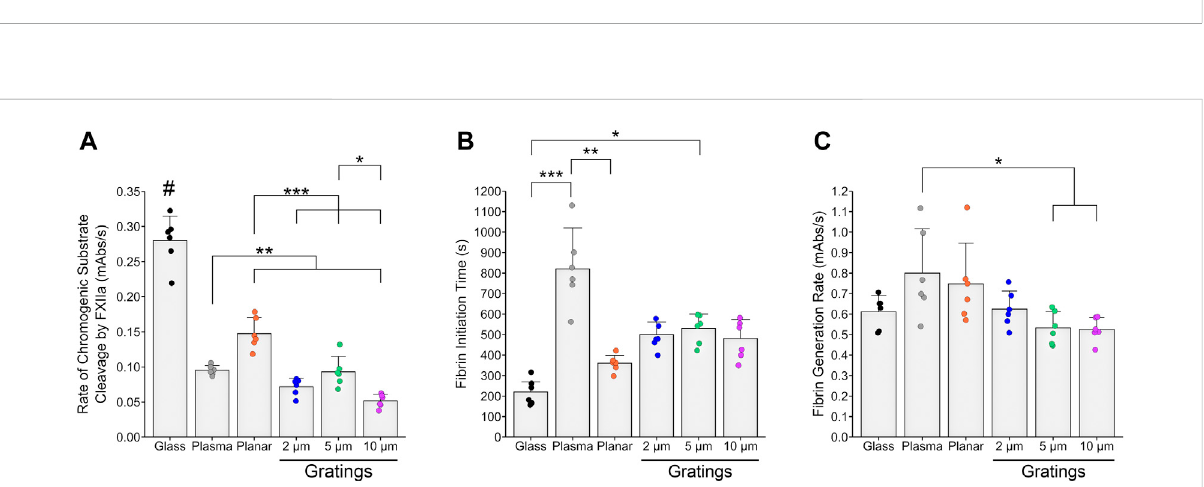
FIGURE 1 Representative images of topographical features. Scanning electron microscope graphs of micropatterned feature sizes for 2 μ m, 5 μ m, and 10 μ m gratings. Scale bars indicate either 1 mm or 20 µm.